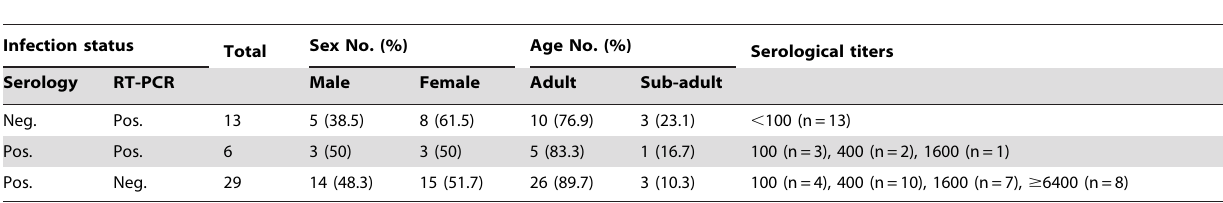
Table 3. Characteristics of Mastomys natalensis with evidence of Lassa virus infection.